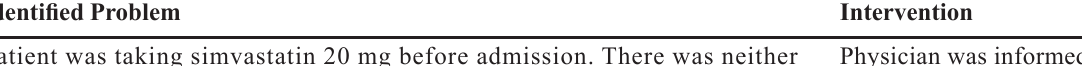
TABLE III - Examples of Drug Related Problems Identified and interventions. Niterói, 2012 Identified